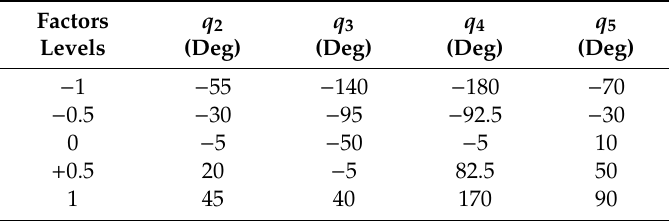
Table 1. Factors and Levels of central composite design (CCD).